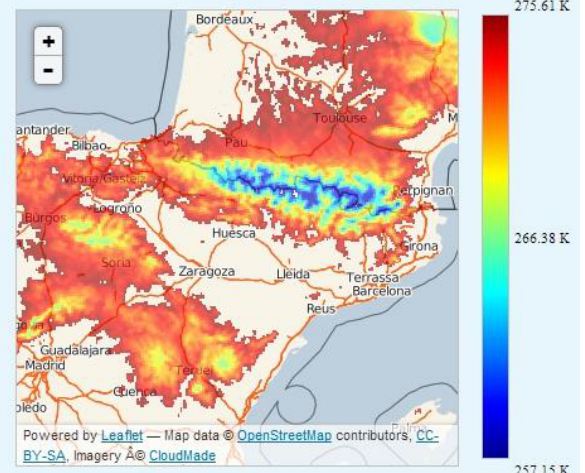
Figure 3. Visualization the forecasted temperature, pressure and wind at surface using OpenLayers library.